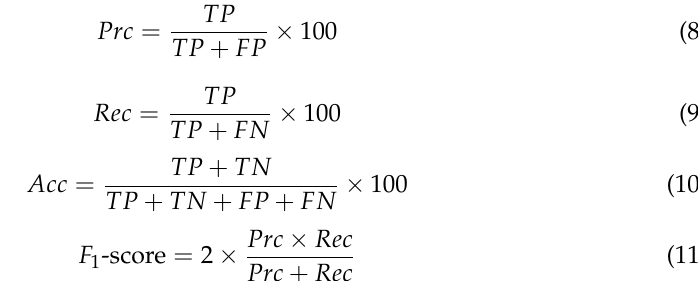
classification—i.e., in the identification of positive versus negative opinions; (2) neutral comments lack information due to their